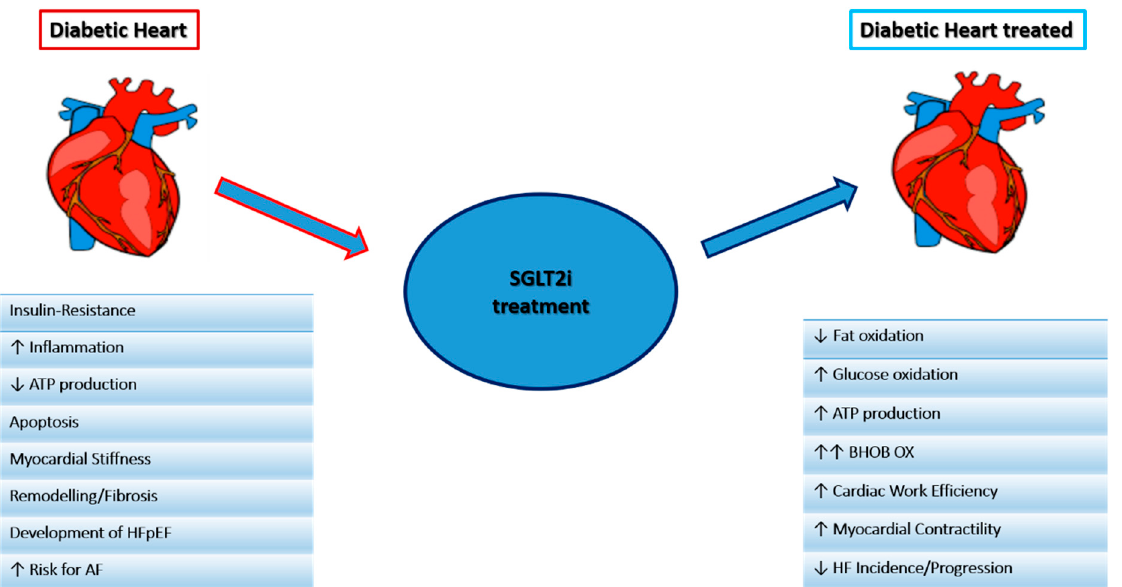
Figure 2. Main mechanisms of the SGLT2i effect on the heart.